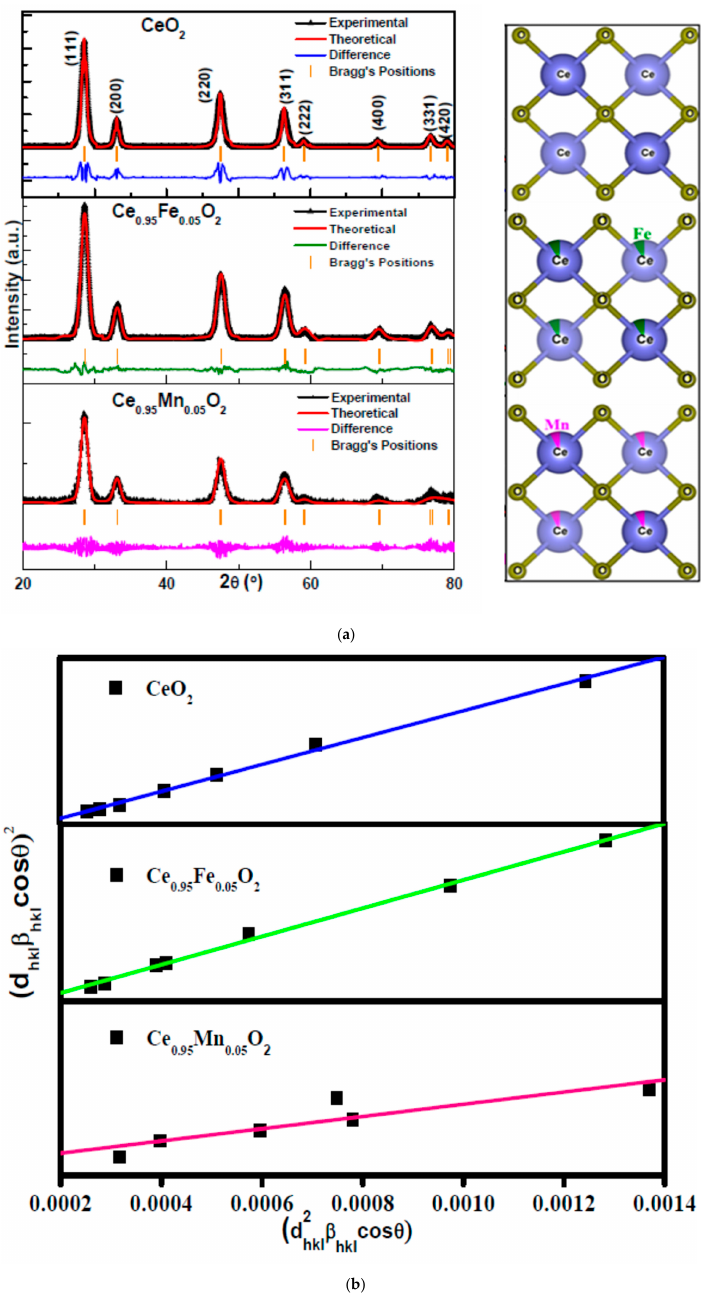
Figure 1. ( a ). Rietveld refined X ‐ ray diffraction patterns of undoped and CeXO 2 along with the re ‐ Figure 1. ( a ). Rietveld refined X-ray diffraction patterns of undoped and CeXO 2 along with the spective images showing incorporation of Fe and Mn in CeO 2 matrix: Experimental data points are shown in colour, the red line shows superimposed theoretically calculated curve, vertical orange respective images showing incorporation of Fe and Mn in CeO 2 matrix: Experimental data points colour lines show Bragg’s positions and blue/green/pink line at the bottom indicate the difference in respective fittings. ( b ) Size ‐ strain plots of undoped and CeXO 2 (X: Fe, Mn) nanoparticles. are shown in colour, the red line shows superimposed theoretically calculated curve, vertical orange colour lines show Bragg’s positions and blue/green/pink line at the bottom indicate the difference in (cid:2870) (cid:3436)𝑘 (cid:4672)𝜀 (cid:4666)𝑑 (cid:3035)(cid:3038)(cid:3039) 𝛽 (cid:3035)(cid:3038)(cid:3039) cos𝜃(cid:4667) (cid:2870) (cid:3404) (1) 𝐷(cid:3440) 𝑑 (cid:3035)(cid:3038)(cid:3039)(cid:2870) 𝛽 (cid:3035)(cid:3038)(cid:3039) cos𝜃 (cid:3397) 2(cid:4673) respective fittings. ( b ) Size-strain plots of undoped and CeXO 2 (X: Fe, Mn) Now, using the aforementioned equation, a plot is made with each diffraction peak’s associated (d 2hkl β hkl cos θ ) term along the X ‐ axis and (d hkl β hkl cos θ ) 2 along the Y ‐ axis, as shown in Figure 1b. The intercept of the straight line provides the intrinsic strain of the nanoparticles, and the slope gives the average size. We observed that the size of the crys ‐ tallites in all samples calculated using the size strain plot is comparable to that determined using the Scherrer method [5]. Rietveld refinement further reveals a shifting in the peak position towards a higher 2 θ value, which indicates the decrease in the lattice parameter as displayed in Figure 2a. Comparing the XRD diffraction peaks (111) of undoped CeO 2 and Fe ‐ and Mn ‐ doped CeO 2 nanoparticles, it is evident that the replacement of some Ce 4+ (0.097 nm) ions by smaller radius Fe 2+ (0.077 nm) ions and Mn 2+ (0.087 nm) ions results in an increase in FWHM with a decrease in the crystallite size of the particles. The crystal ‐